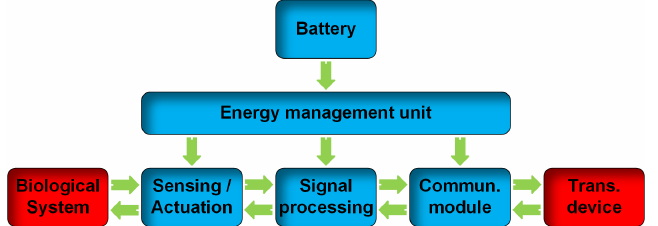
Figure 1. General block diagram of an implantable device with